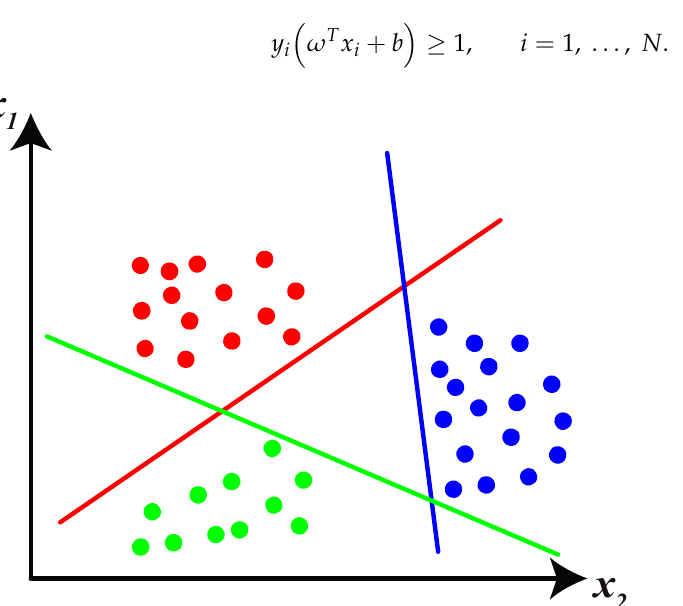
Figure 3. SVM classifier representation with linear kernel for two-dimensional data set.